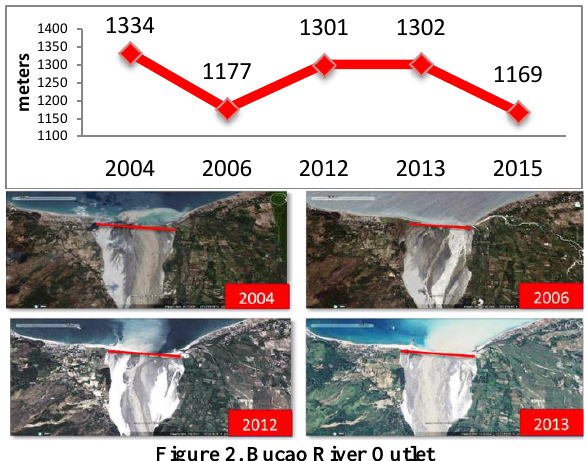
Figure 2. Bucao River Outlet